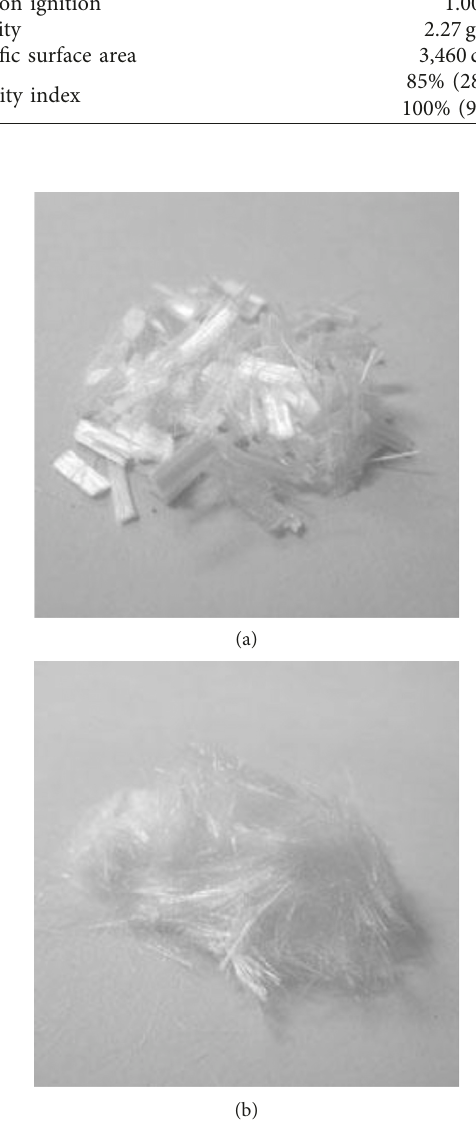
Figure 1: Sample of fibers: (a) polyethylene fiber; (b) polyvinyl alcohol